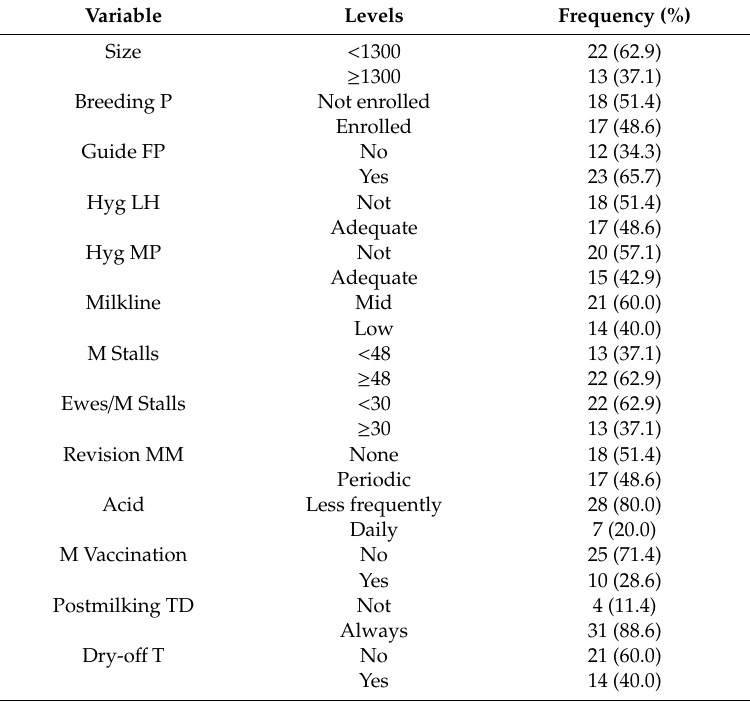
Table 4. Distribution of frequencies obtained in the applied questionnaire.